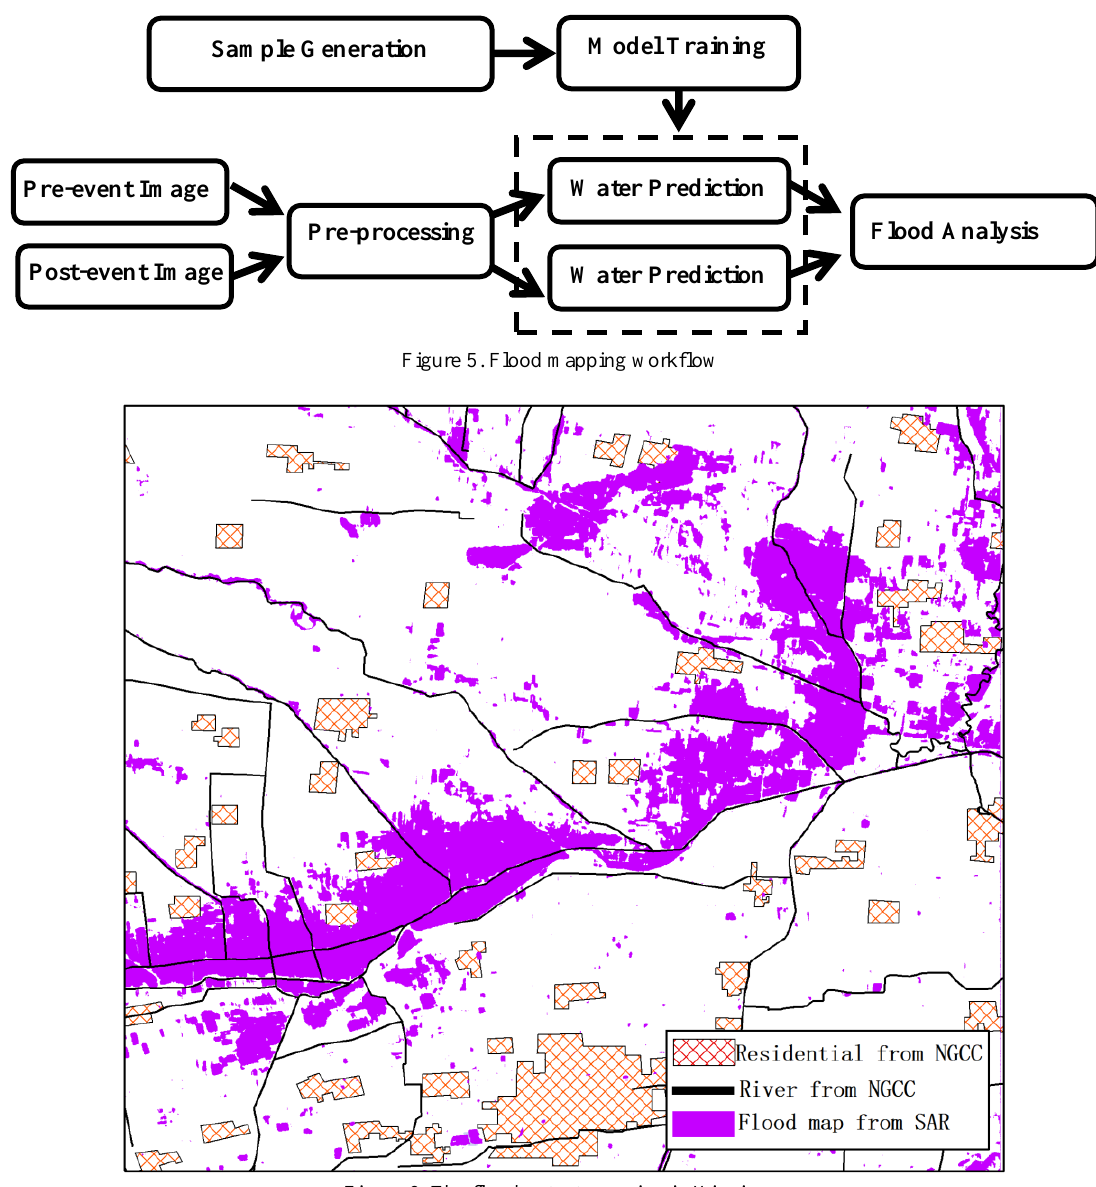
Figure 6. The flood extent mapping in